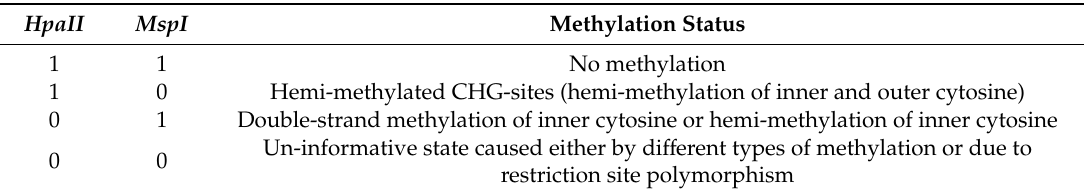
Table 1. Restriction enzyme behaviour: Msp I and Hpa II sensitivity to methylation at cytosines in their digestion